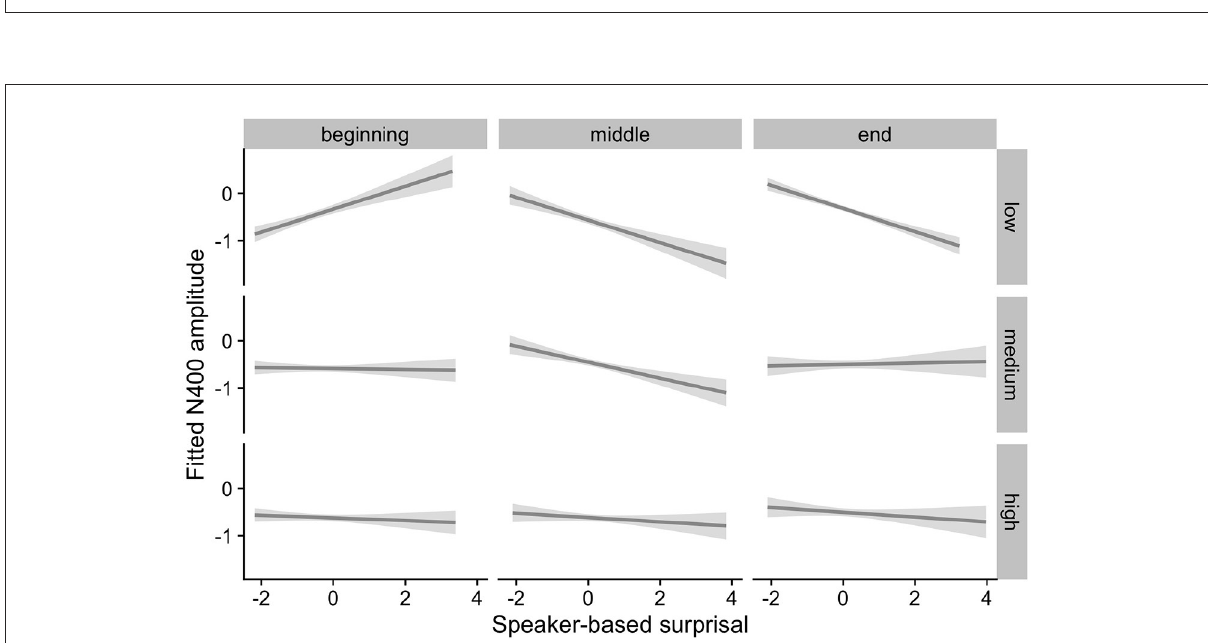
FIGURE12 Effects of ID on changes in the relationship between speaker-based surprisal (z-transformed) and N400 amplitude over the course of the experiment in the combined analysis of Experiments 1 and 2 ( n = 85). The figure visualizes partial effects as calculated using the remef package, adjusted for Prestimulus Amplitude, Frequency and Canonicity. Note that position in the experiment (operationalised via epoch in the statistical model) is trichotomised into beginning, middle and end for visualization purposes only; epoch was included in the model as a continuous predictor. The same holds for the individual differences variables, which are trichotomised for visualization purposes but were entered into the statistical models as a continuous predictors. Shaded areas indicate 95% confidence